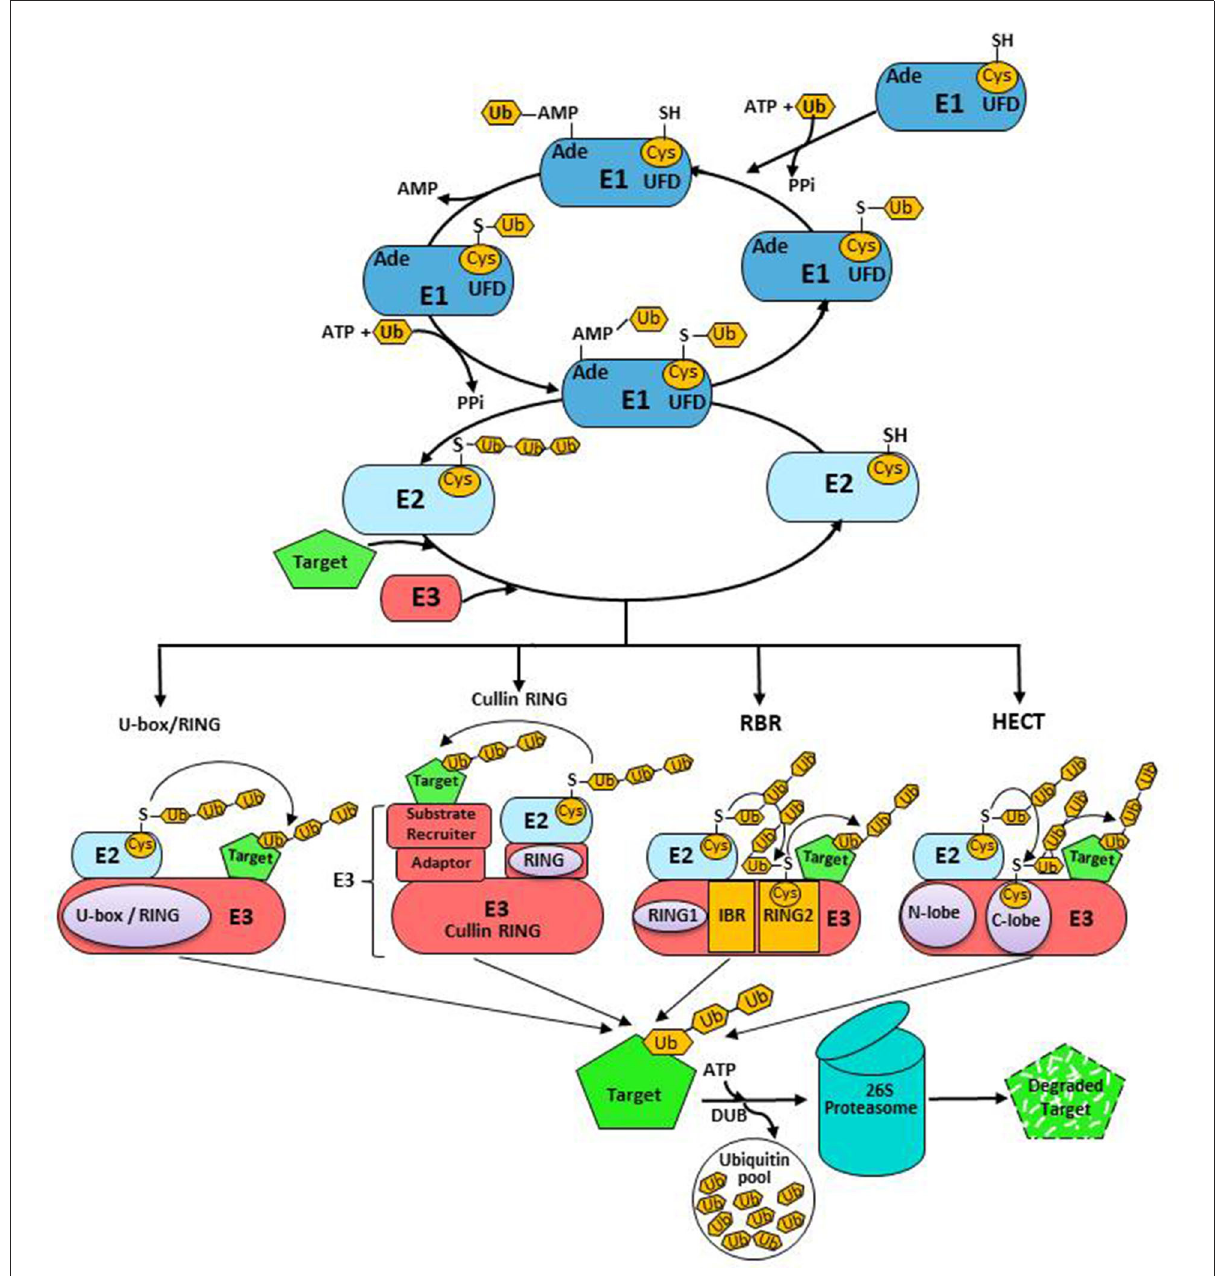
FIGURE3 The ubiquitination cascade: Ub conjugation system undergoes ATP-dependent Ub activation and formation of thioester with E1. Subsequently, Ub is transferred to E2. E3 catalyzing Ub transfer to substrates is divided into RING, Cullin RING, HECT, and RBR classes. DUBs catalyze the removal of Ub from